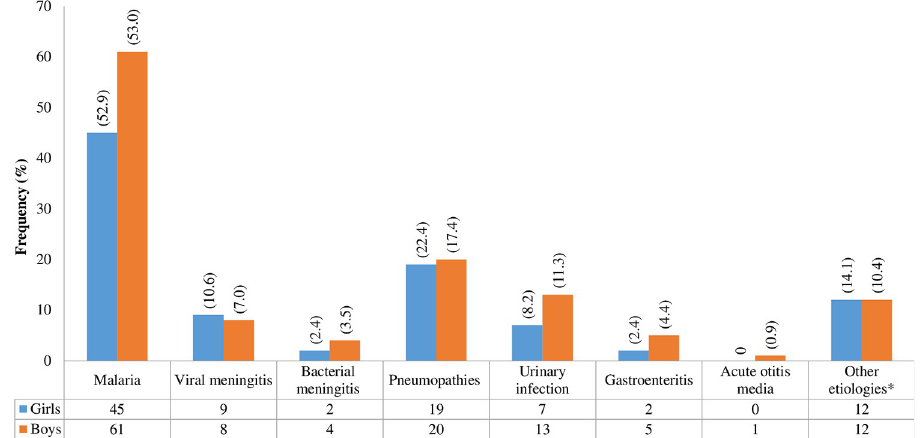
Fig 3. Confirmed diagnostic. Note. � , abscess; viral conjunctivitis; fever with unknown origin; bypass drain infection; osteoarticular infection; moderate/severe/acute malnutrition; myositis sepsis; esophageal stenosis; pulmonary tuberculosis associated with urinary